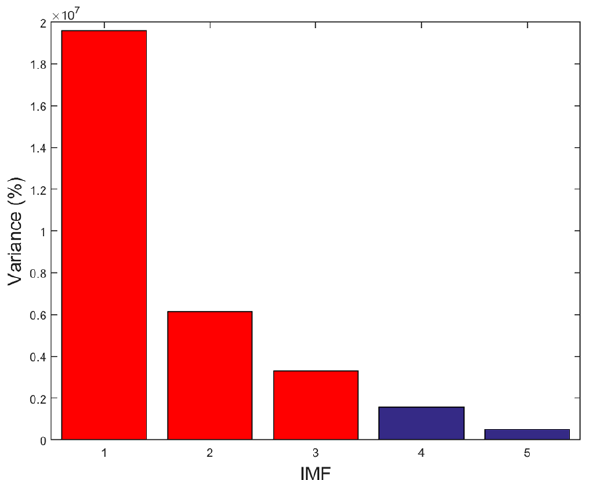
Figure 4. Variance of IMFs of precipitation using EMD algorithm over Caspian catchment. IMF1, IMF2 and IMF3 (red bars) are significant IMFs among others IMFs.